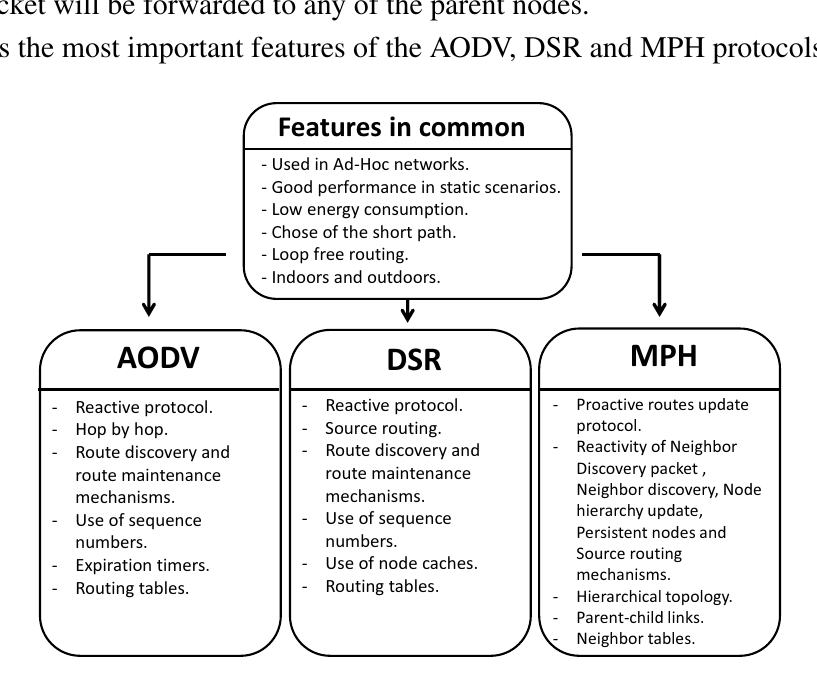
Figure 1. Important features of the ad hoc on-demand distance vector (AODV), dynamic source routing (DSR) and multi-parent hierarchical (MPH)